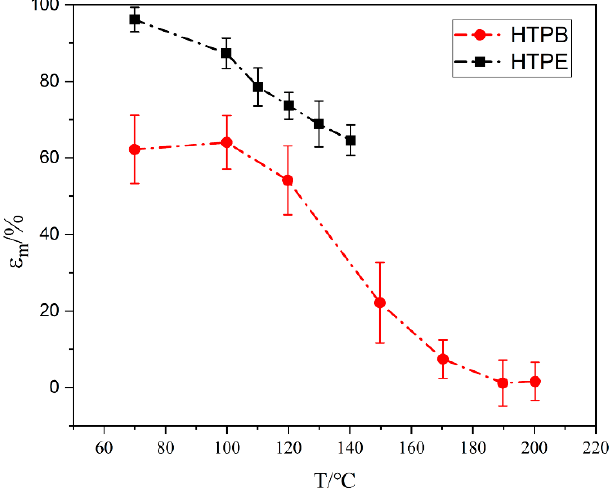
Figure 18. The relationship between maximum elongation and temperature in HTPB and HTPE propellant.